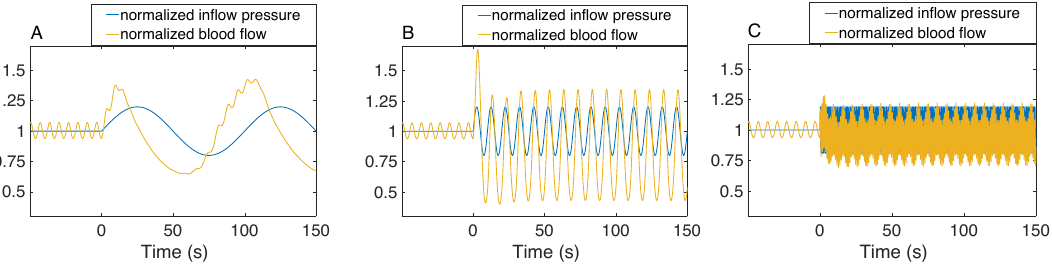
Figure 11. Normalized inflow pressure P a / P ref a and normalized blood flow Q AA / Q ref a sinusoidal perturbation is applied to the inflow pressure with amplitude A = 20 mmHg and frequency ( A ) 0.01 Hz; ( B ) 0.1 Hz; and ( C ) 1